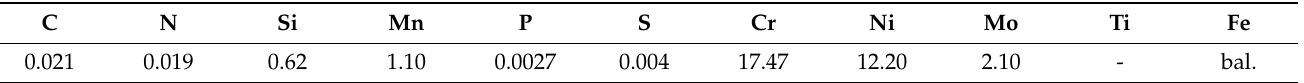
Table 1. Chemical composition of AISI 316L in wt.